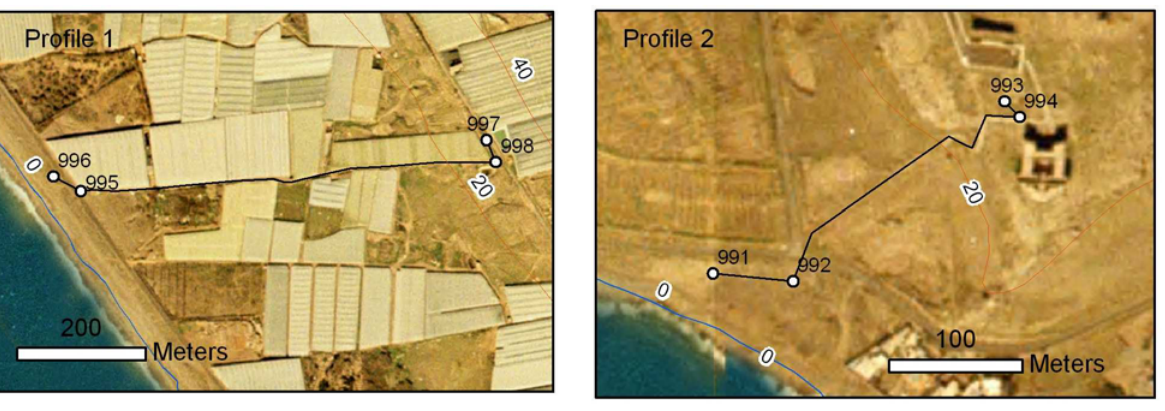
Figure 6. Detailed location of levelling profiles in the Balanegra Fault